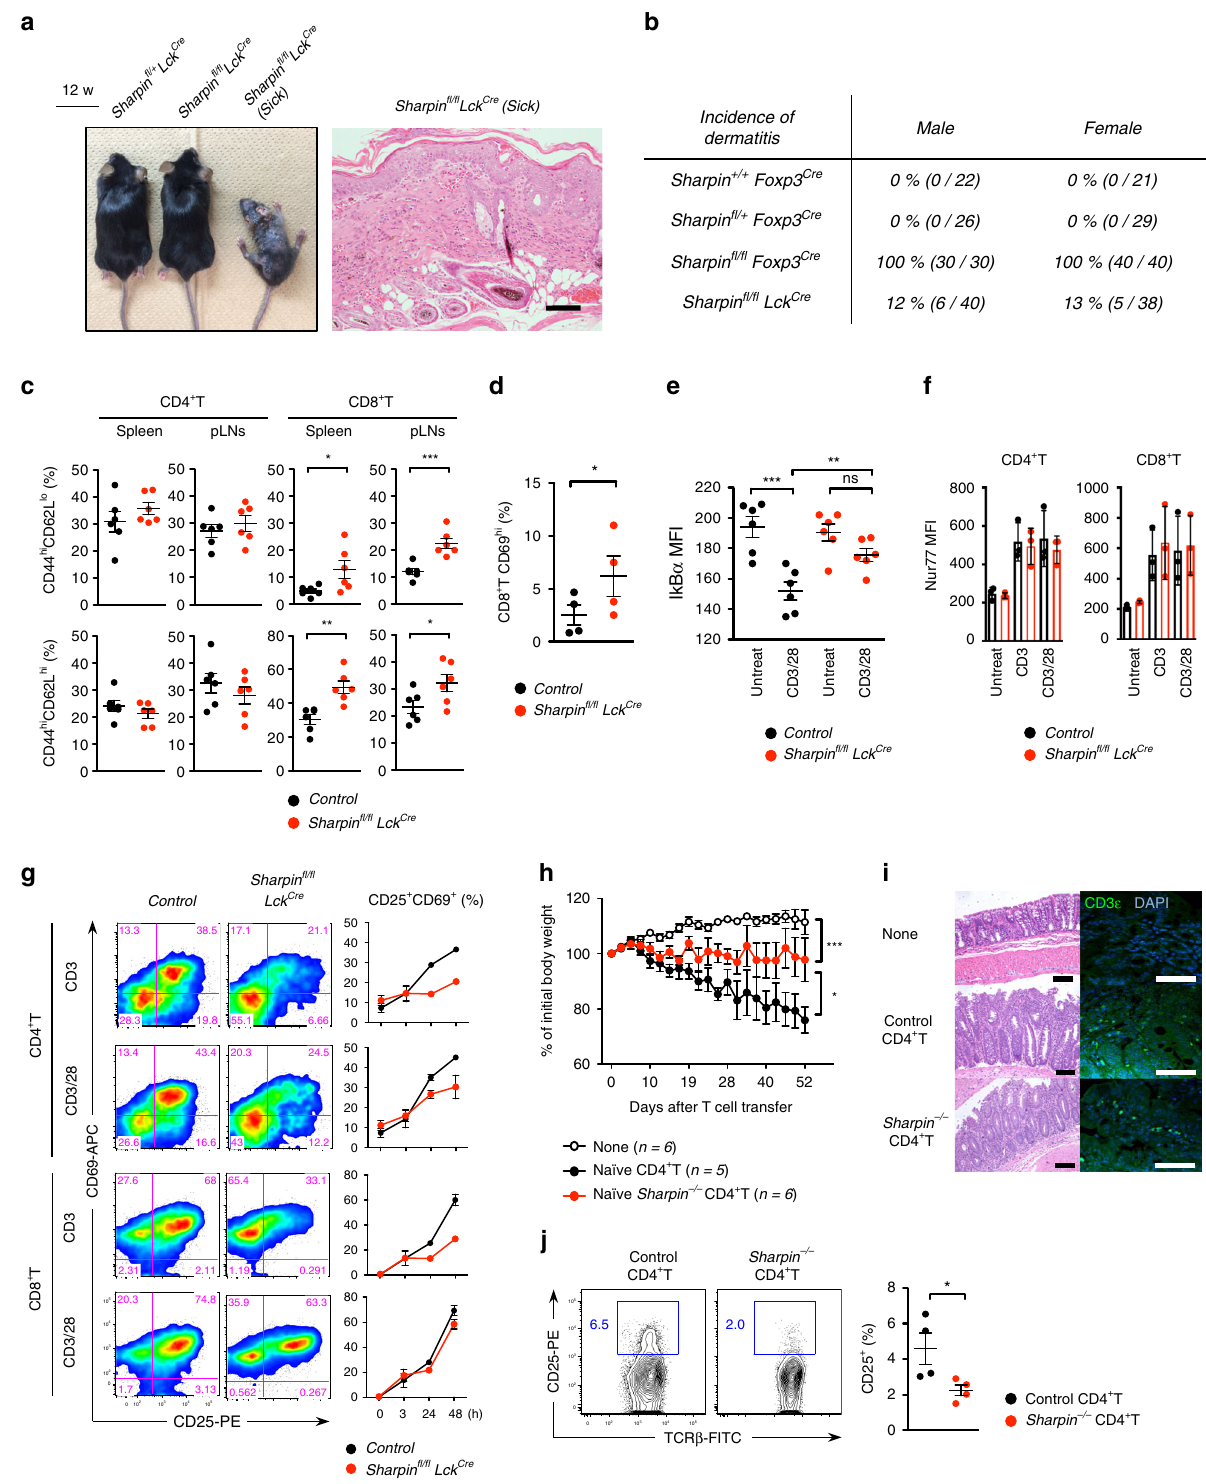
proin fl ammatory (IL-6, TNF α , and IL-1 β ) and allergy-related (TSLP) cytokines was very similar in Sharpin fl / fl Foxp3 Cre and Sharpin fl / fl K5 Cre mice (Fig. 4d). However, there were some dif- ferences between Sharpin fl / fl Foxp3 Cre and Sharpin fl / fl K5 Cre mice based on etiology. Peripheral granulocytes in Sharpin fl / fl K5 Cre , but not Sharpin fl / fl Foxp3 Cre , mice showed increased IL-6-mediated STAT3 phosphorylation, which is indicative of cytokine-